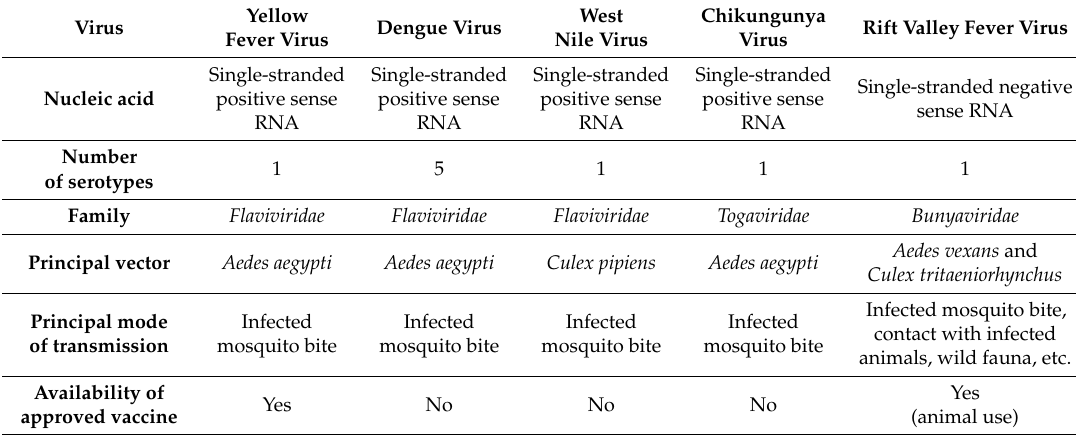
Table 1. Characteristics of some arboviruses.